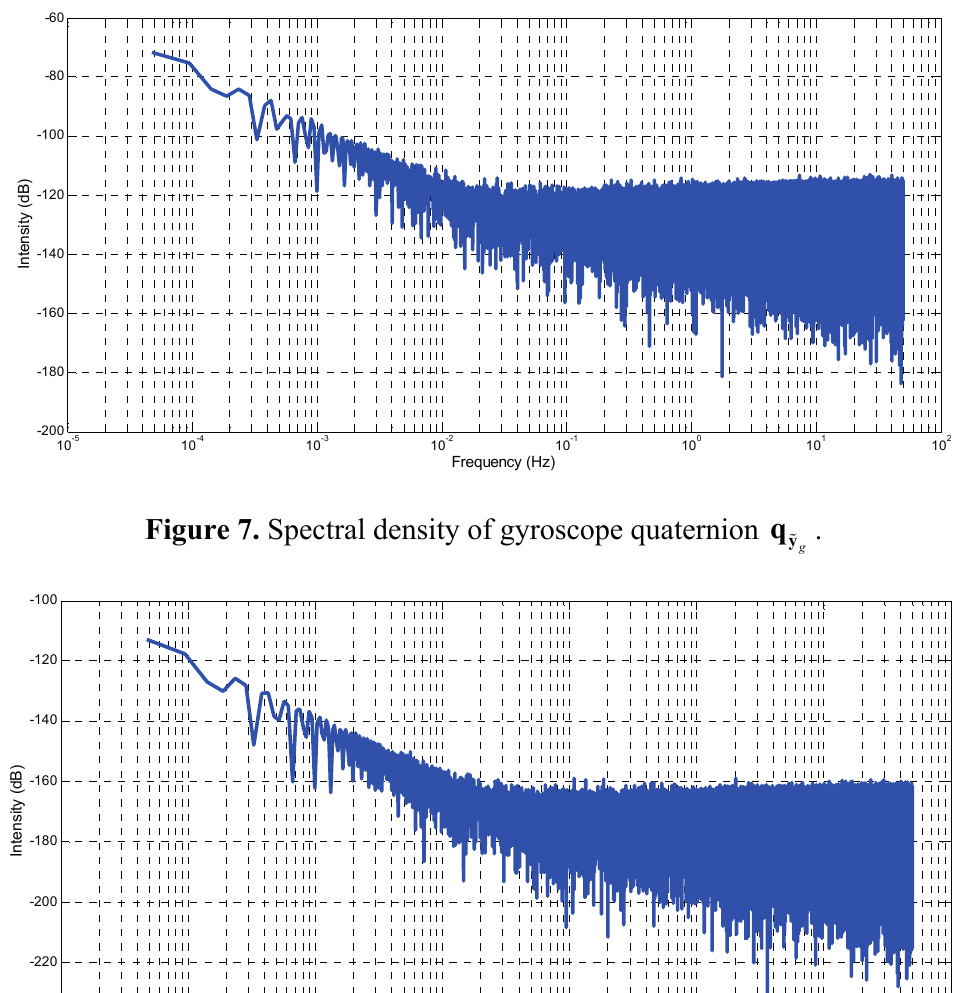
Figure 6. Spectral density of the simulated gyroscope signal